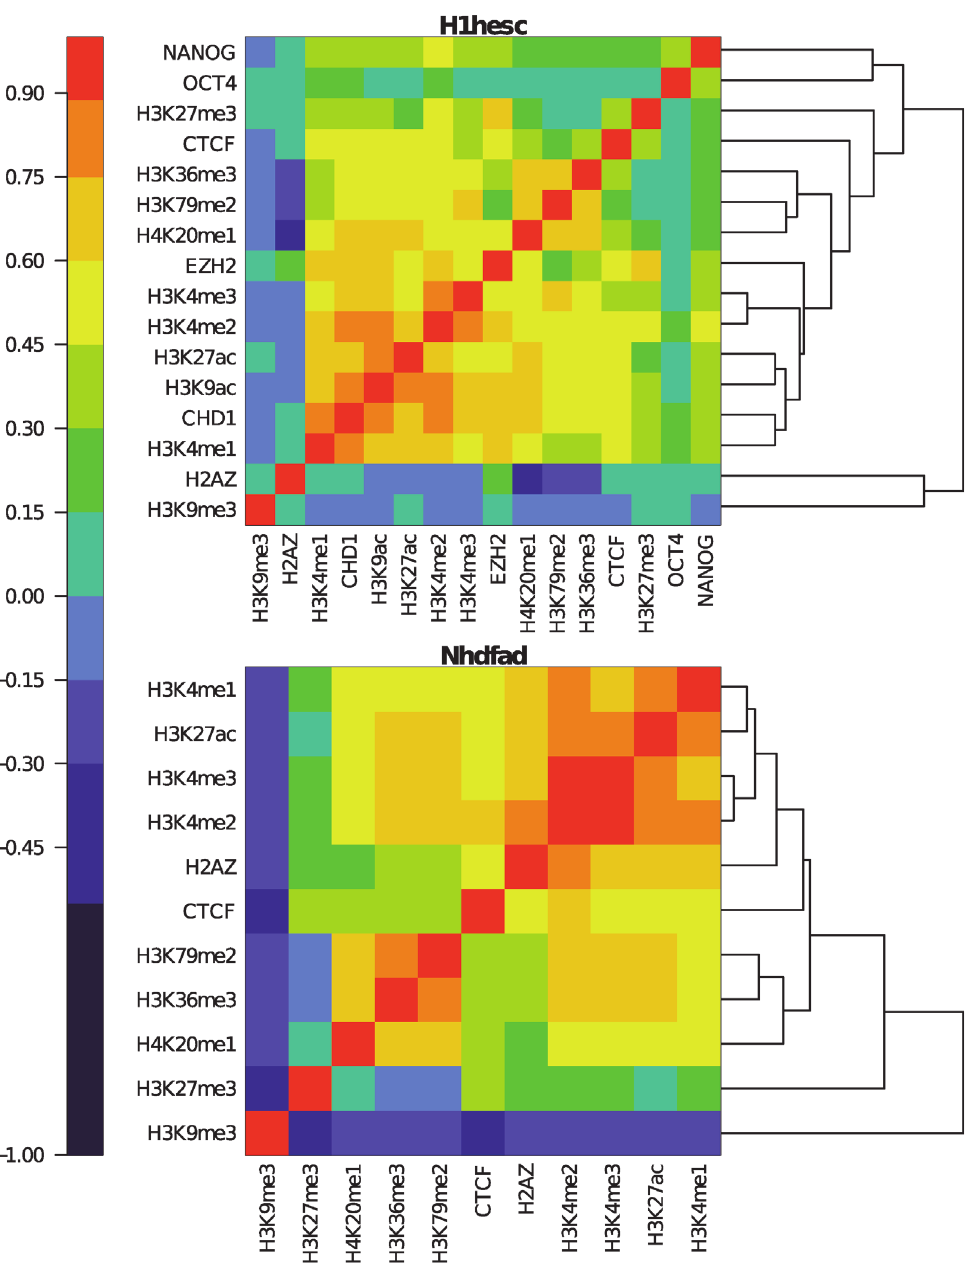
Figure 1. Spearman correlation matrix between epigenetic marks in H1hesc (top) and Nhdfad (bottom). For each cell line, we computed the Spearman correlation over all 100 kb non-overlapping windows with a valid score. Spearman correlation value is color coded using the color map shown on the left. Lines for the epigenetic marks were reorganized by a hierarchical ordering using Spearman correlation distances [Equation (1)] as illustrated by the dendrograms on the right of the corresponding matrices. This ordering implies that highly correlated epigenetic marks are close to each other.